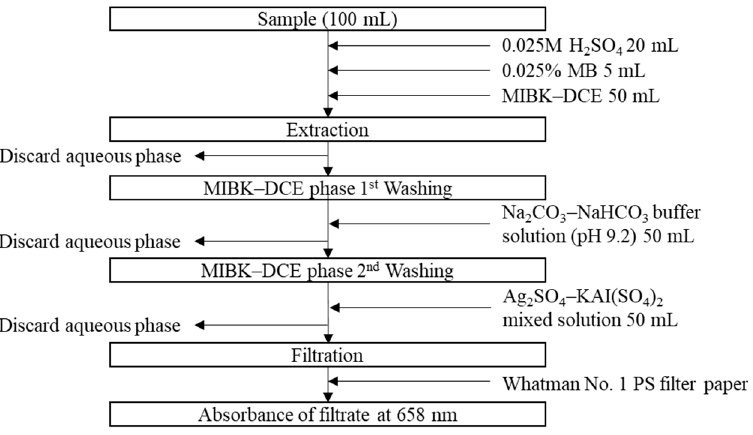
Figure 1. Experimental procedures of the MIBK-DCE